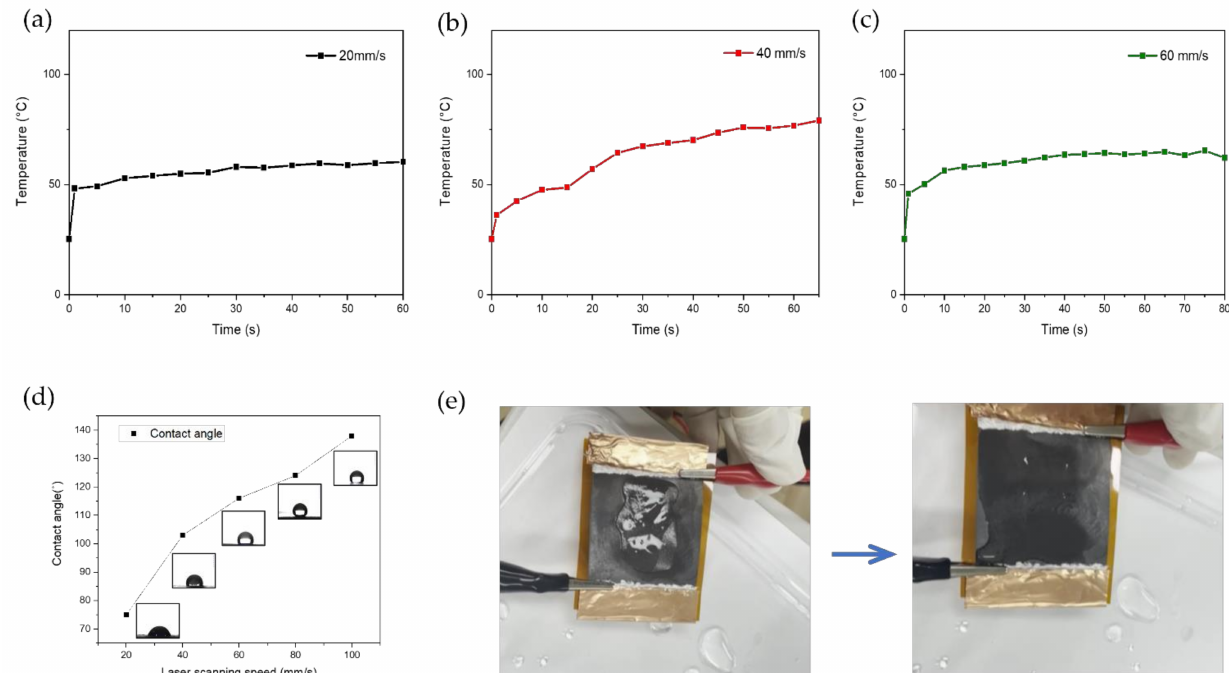
Figure 7. Temperature change plot for de-icing of LIG heater (50 mm × 50 mm) fabricated at a laser scanning speed of ( a ) 20 mm/s, ( b ) 40 mm/s, and ( c ) 60 mm/s during Joule heating of 12 V. ( d ) Contact angle depending on the laser scanning speed. ( e ) De-icing test of water droplet (3 mL) with LIG